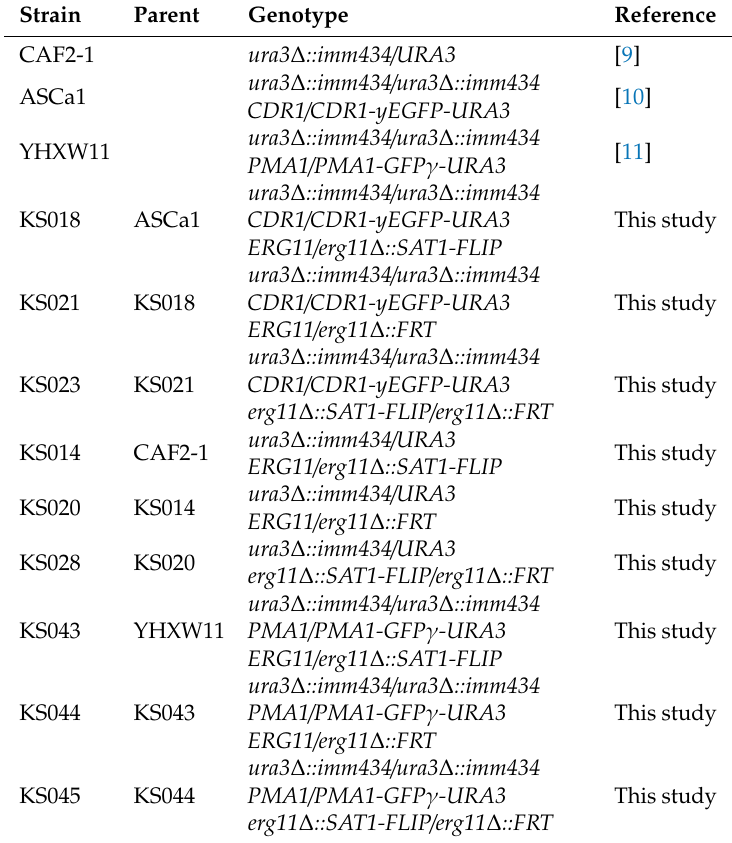
Table 1. C. albicans strains used in this